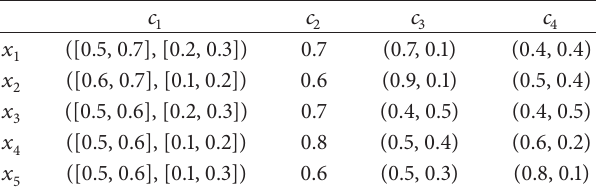
Table 1: Evaluation information at 𝑡 1 time episode.